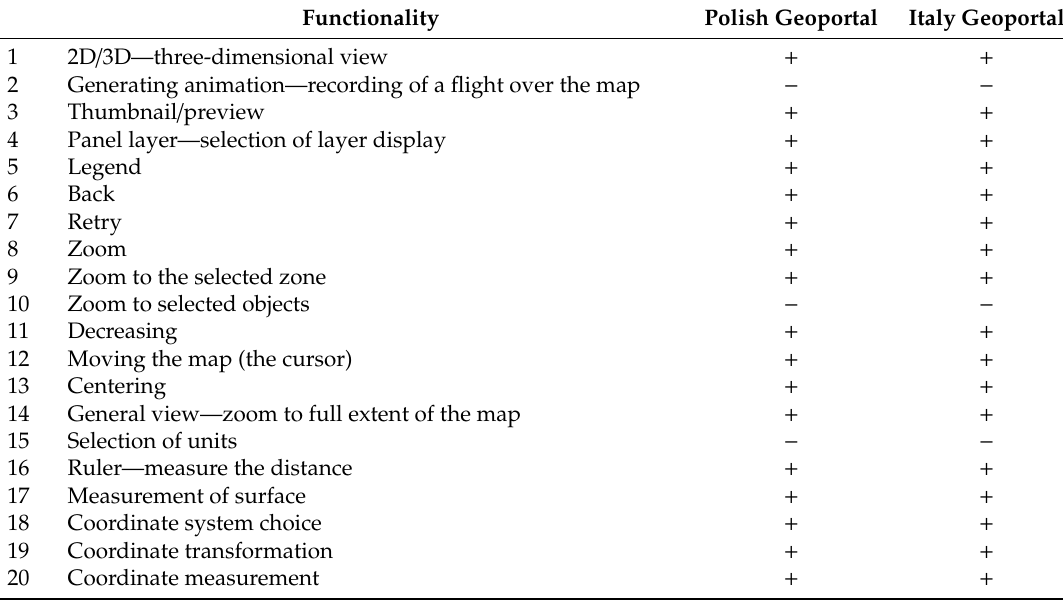
Table 1. Geoportal functionalities (data and service coverage), own study based on data from Raport https://inspire.ec.europa.eu/documents/summary-report-status-implementation-inspire-directive-eu and [1].